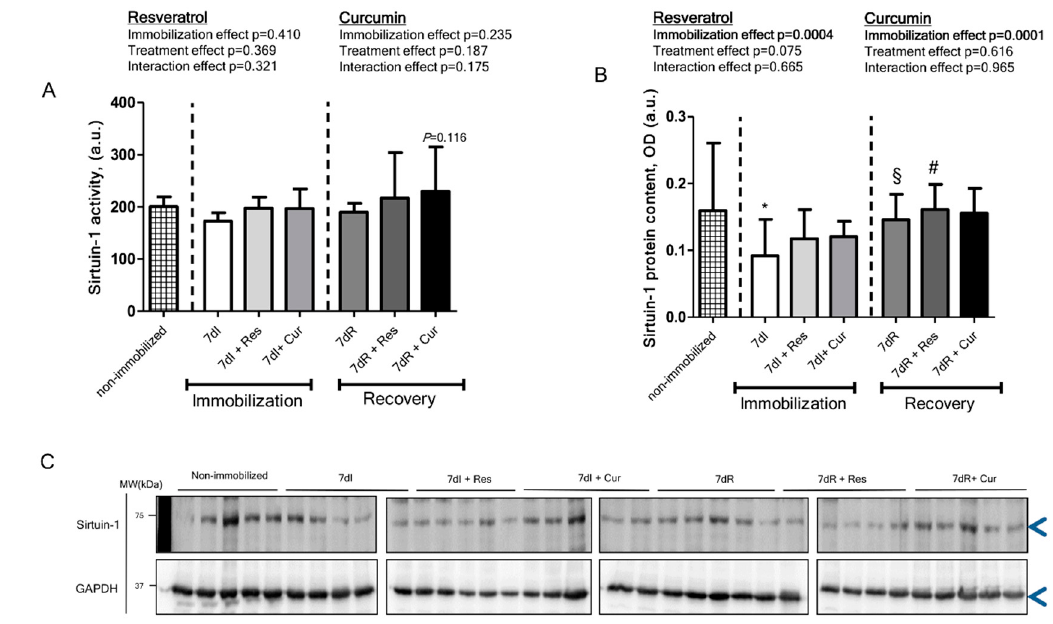
Figure 3. ( A ) Mean values and standard deviation of sirtuin-1 activity levels in the